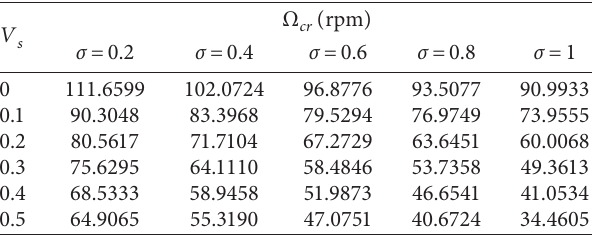
Table 5: The critical rotating speed corresponding to the different SMA wires fractions and taper ratio for C-F boundary